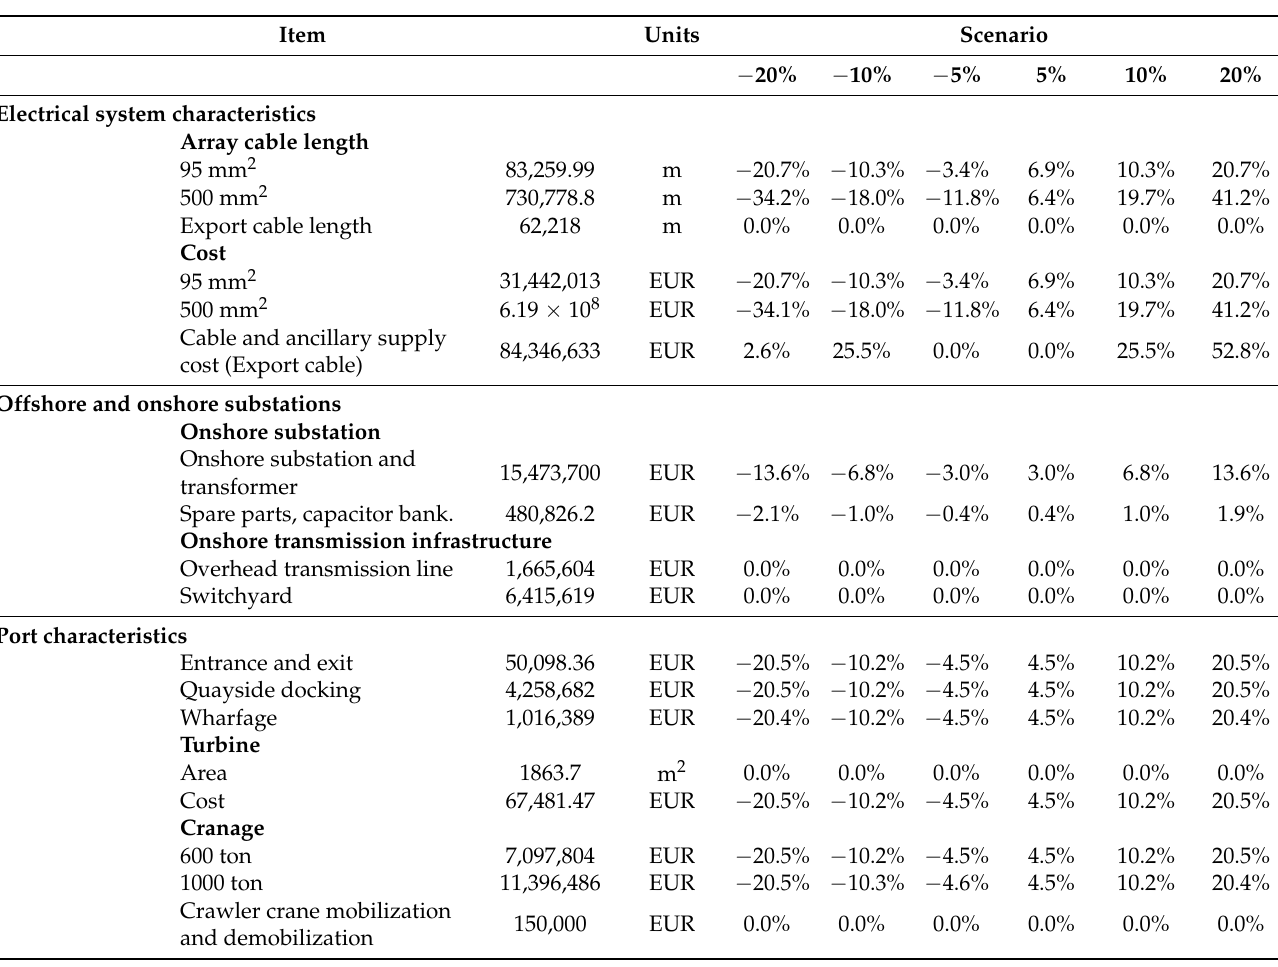
Table A1. Variability associated with the number of